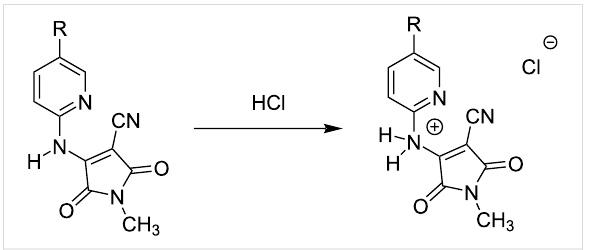
Figure 4: Protonation of N -methyl-4-((pyridin-2-yl)amino)-substituted maleimides 4 by 0.1 M